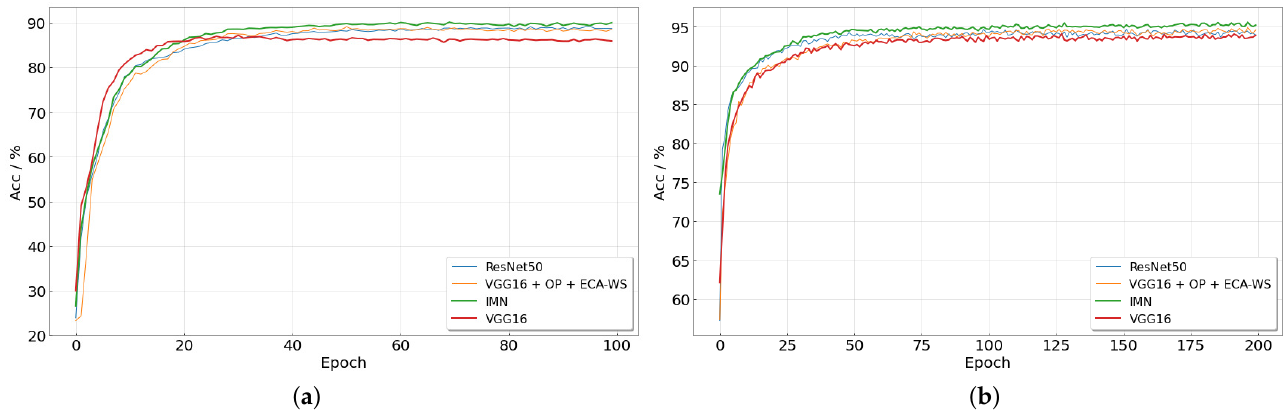
Figure 10. Experimental results of different datasets. ( a ) Accuracy of MGCD, ( b ) accuracy of NRELCD.